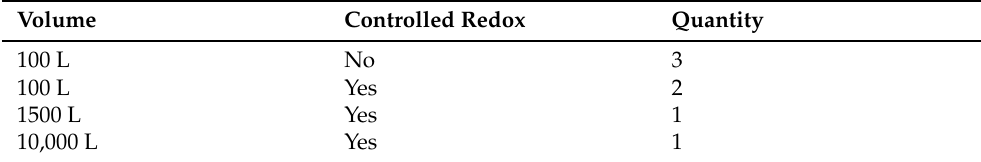
Table 2. Description of the fermentation